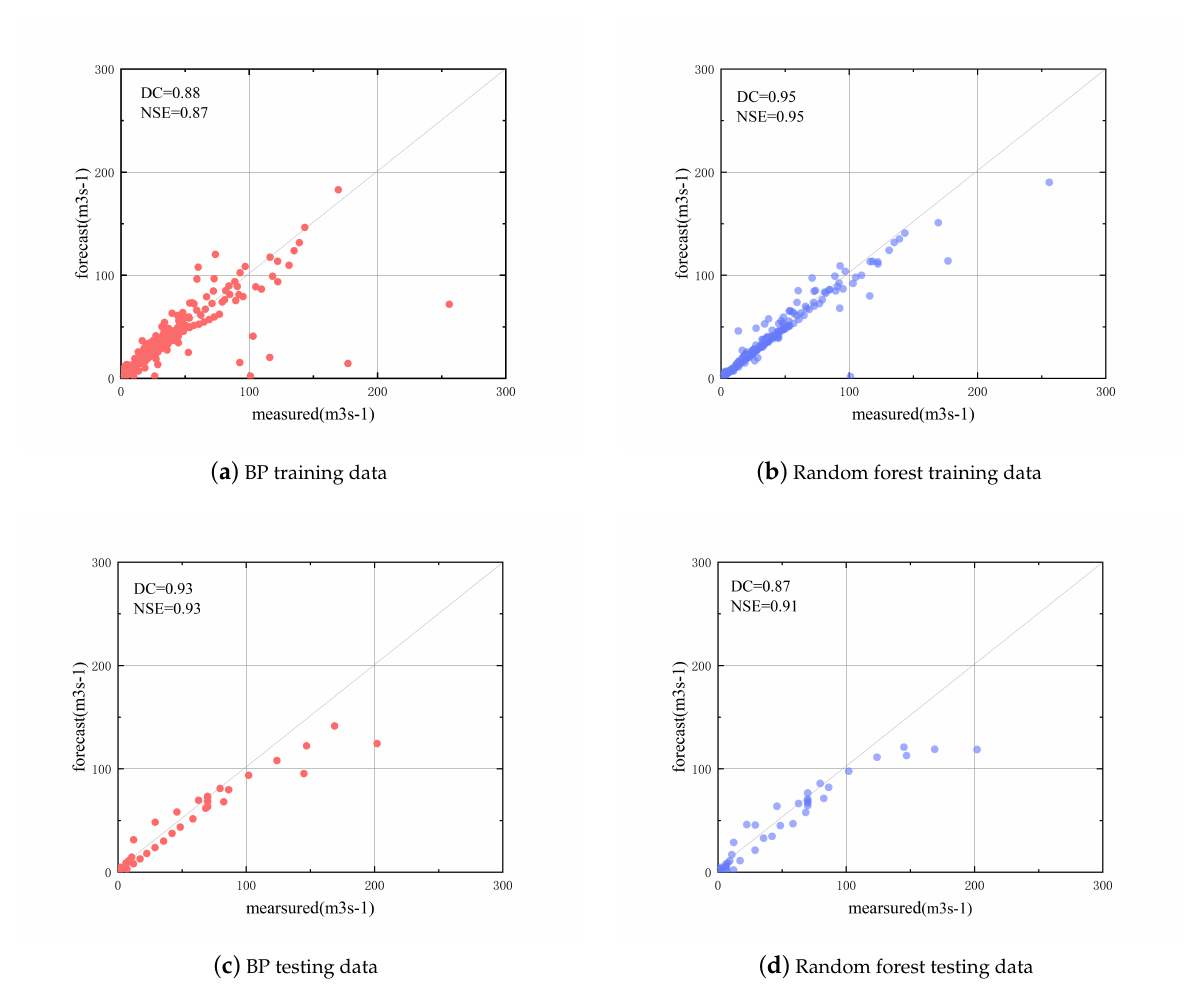
Figure 11. Scatter pictures of BP neural network and random forest for